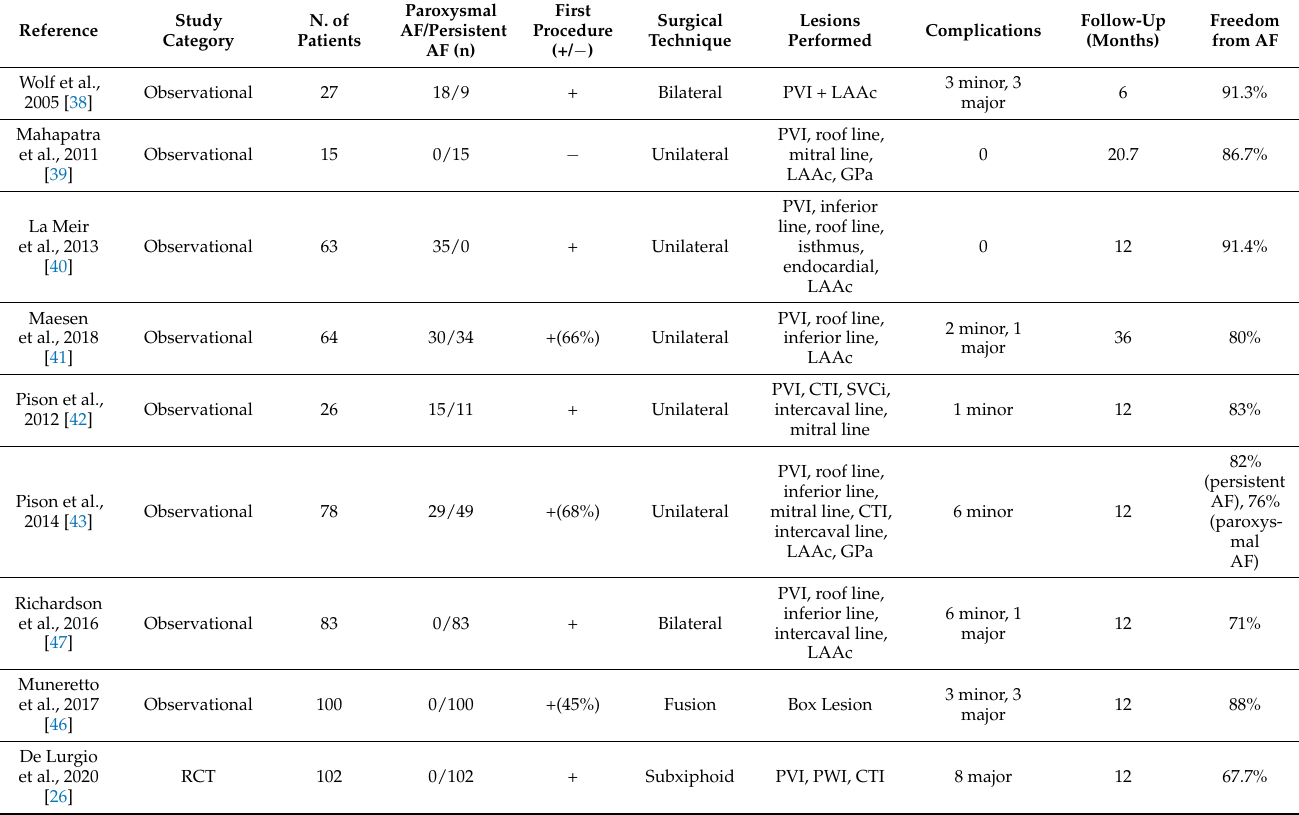
Table 1. Summary of studies on hybrid atrial fibrillation